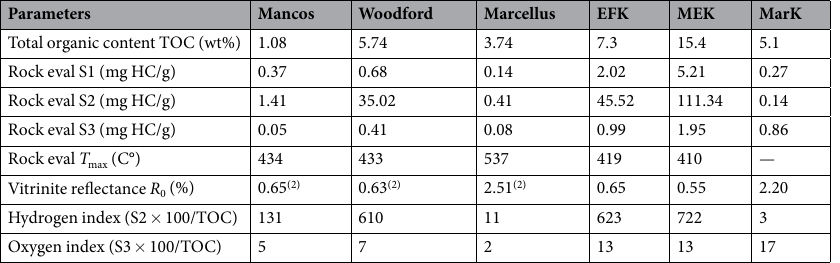
Table 1. Experimental characteristics of the Mancos, Woodford, Marcellus, EFK, MEK and MarK kerogen samples (1) . (1) EFK, MEK and MarK characterization from ref. (5). (2) Calculated with R 0 = [(0.018 * T max ) − 7.16].